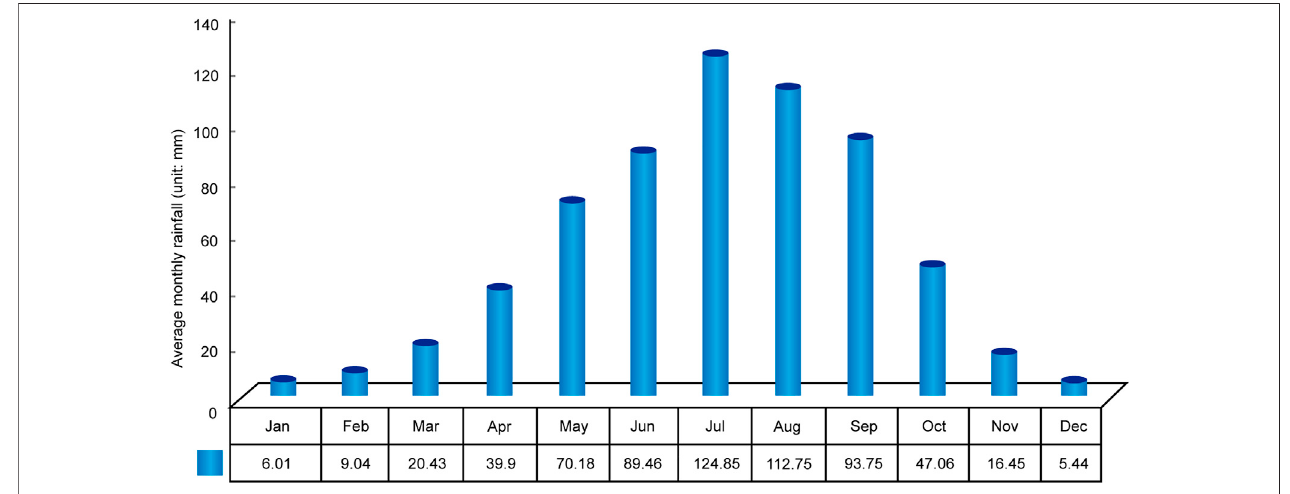
FIGURE 3 | Average water vapor fl ux in eastern Northwest